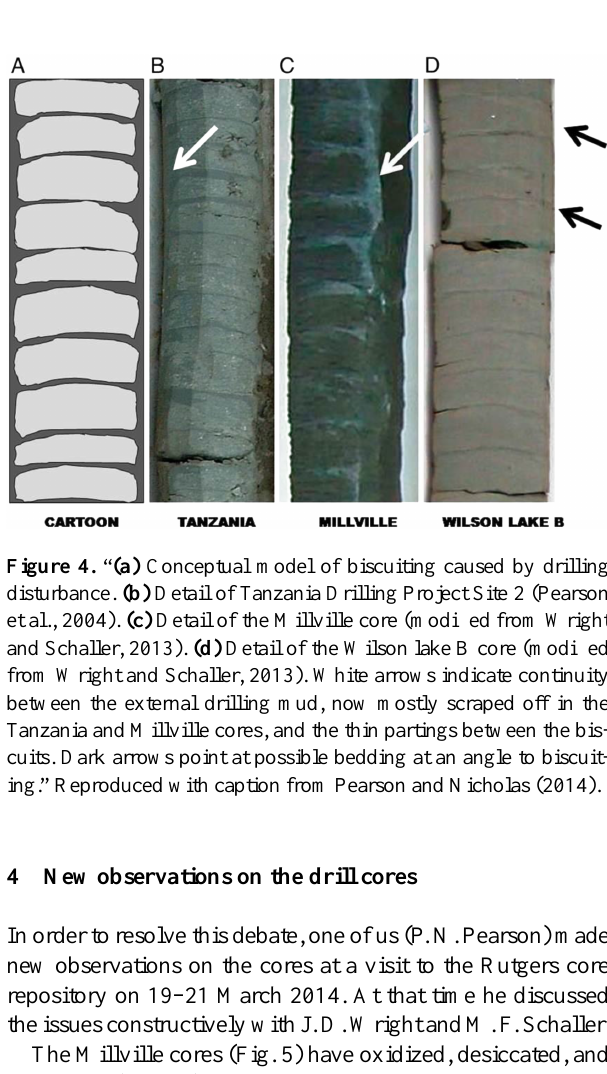
Figure 3. “Types of drilling deformation in Leg 66 cores” reproduced with caption from Leggett (1982).